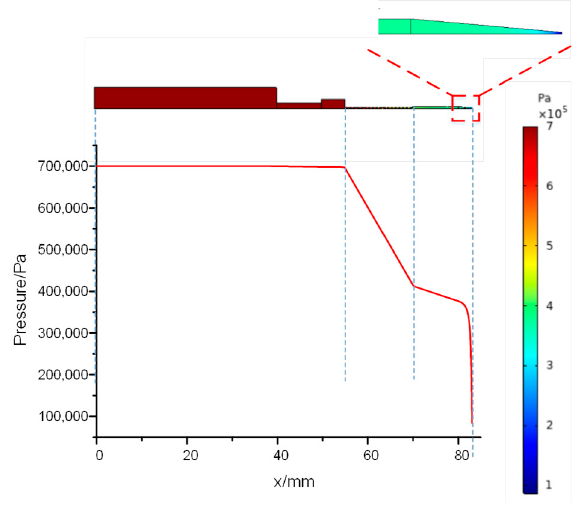
Figure A2. Simulation result graph of the feeding pressure (0.7 MPa).